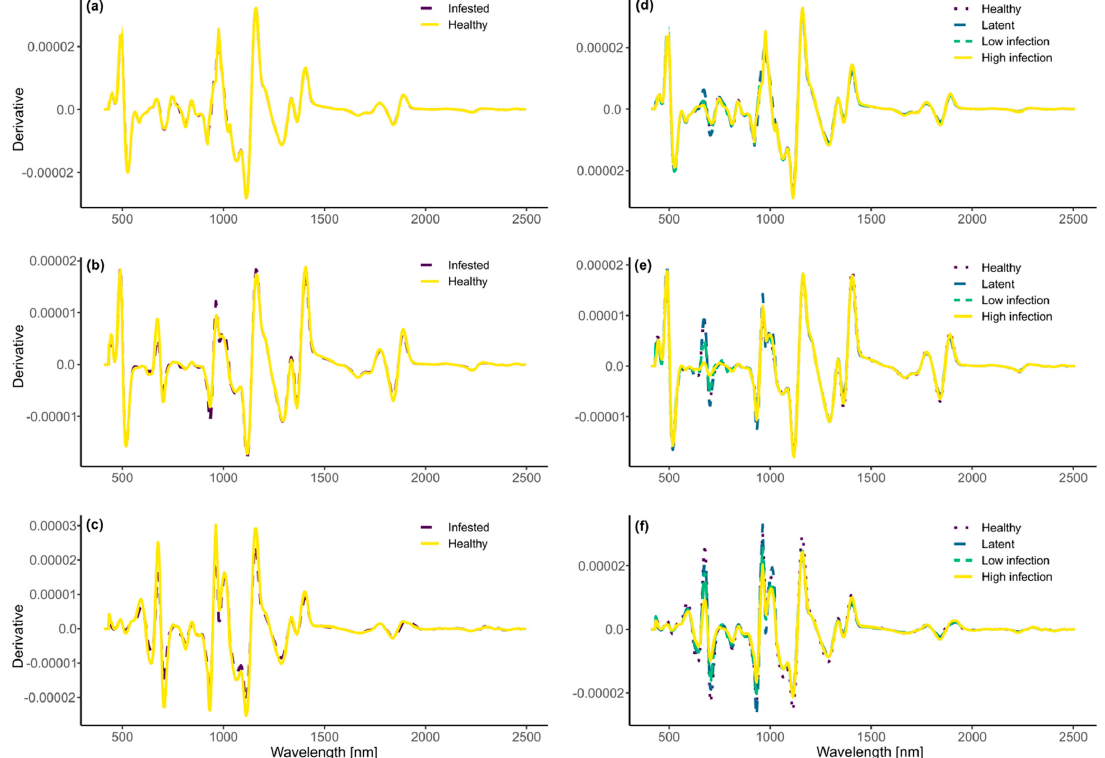
Figure 5. Savitzky–Golay derivative spectra. Left column: distinguishing between healthy and infested tubers; Right column: distinguishing between infestation severity groups. ( a , d ) internal data, ( b , e ) peel data, ( c , f ) external data.